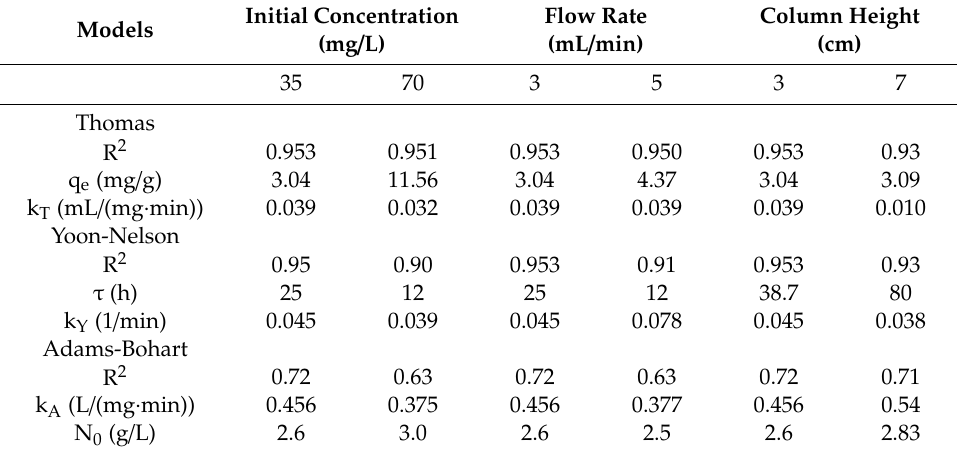
Table 2. The summary of experiment parameters calculated from di ff erent models under various experimental